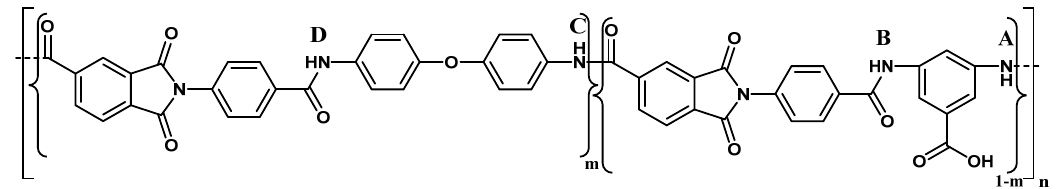
Figure 2. Structural formulas of PAI-1 (m = 1), PAI-2 (m = 0) and copolymers coPAI-1 (m =